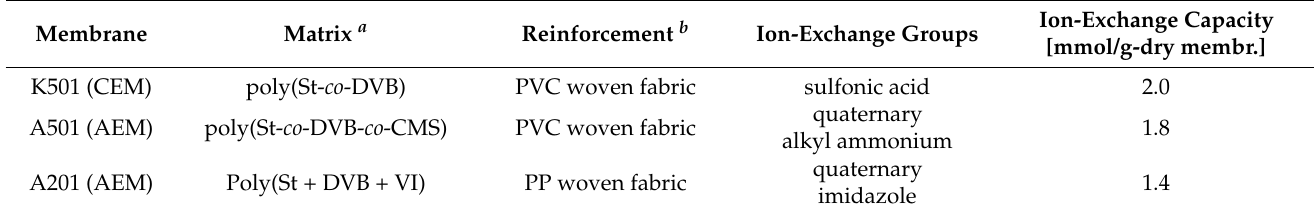
Table 2. Physicochemical properties of ion-exchange membranes (IEMs) used for